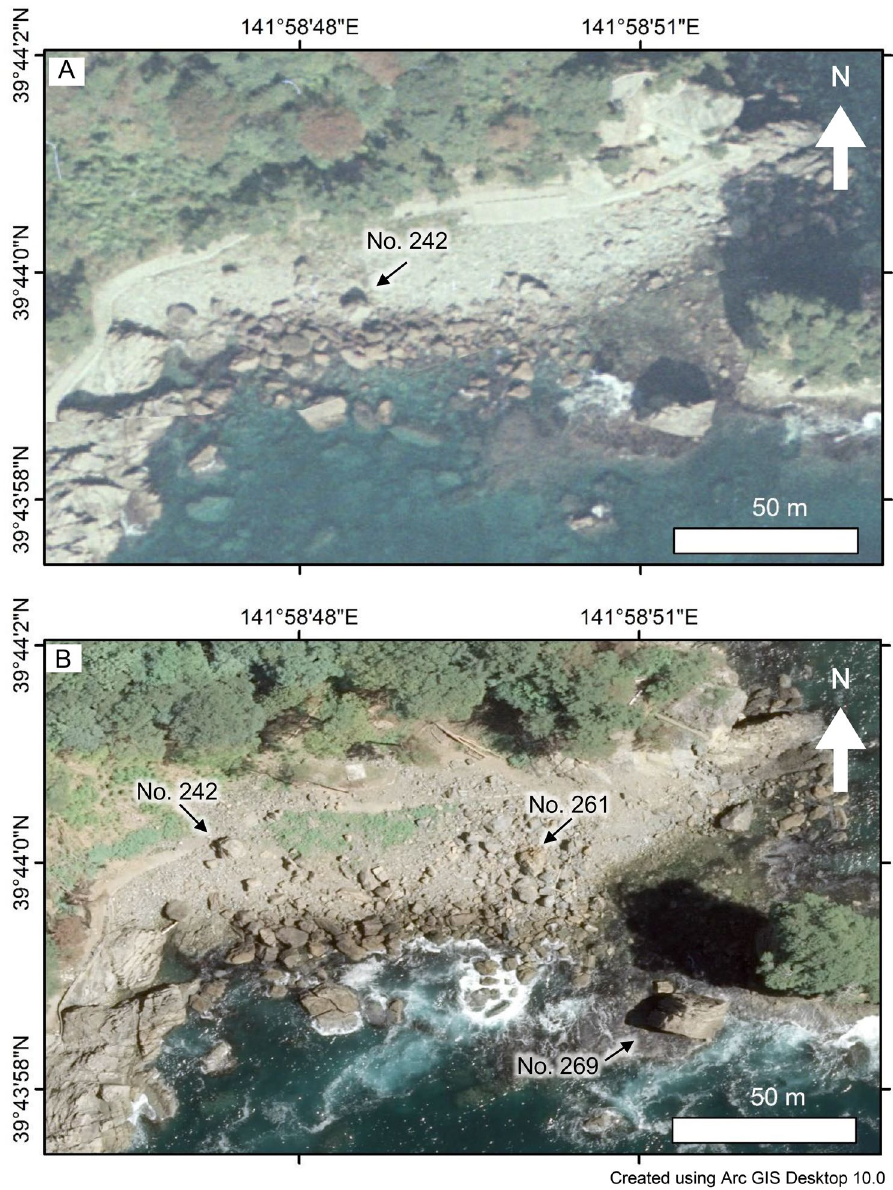
Figure 2. Aerial photographs, provided by Geospatial Information Authority of Japan (GSI), around “Sanno- iwa Rocks” in Miyako City, where was studied earlier by Nandasena et al. 6 , which were overlaid with using Arc GIS Desktop 10.0: ( A ) October 21, 1977 and ( B ) July 11, 2011. Numbers of boulders correspond to the Table in the Supplemental Information. No. 269 is the one in Fig. 3B. No. 242 was moved but No. 269 was not